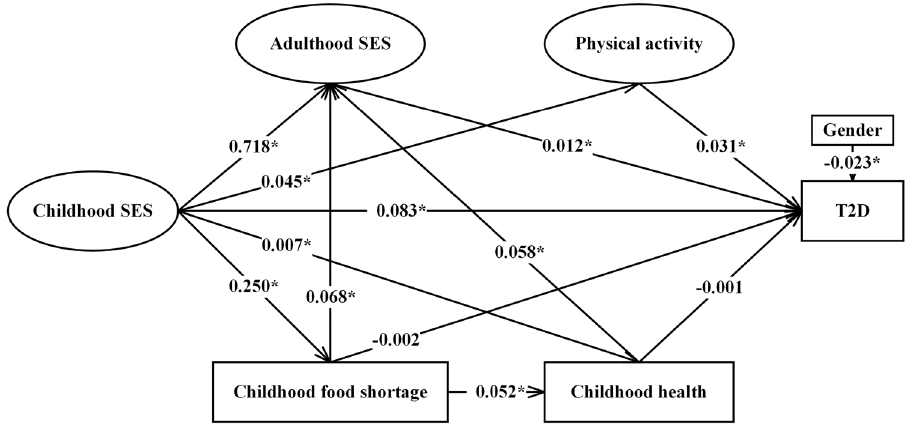
Figure 2. Standardized estimates of the pathways from childhood SES to T2D in mid-late adulthood in the model. * p < 0.05. SES socioeconomic status, T2D type 2 diabetus. Fitting of the model: CFI=0.809; AGFI = 0.970; GFI = 0.978; RMSEA = 0.054; SRMR = 0.040.